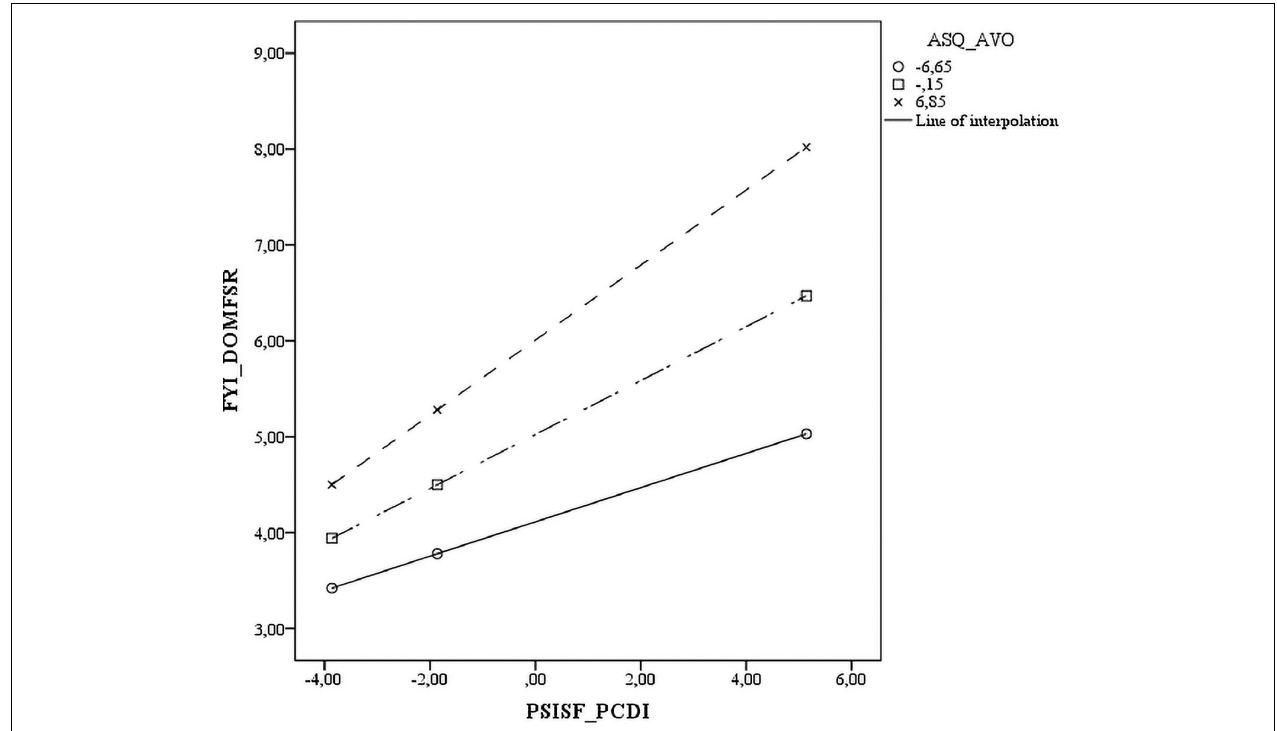
FIGURE 5 | Scatter plot of the interaction between anxious attachment style and parent-child dysfunctional interaction on the socio communicative domain on the sensory regulation domain.